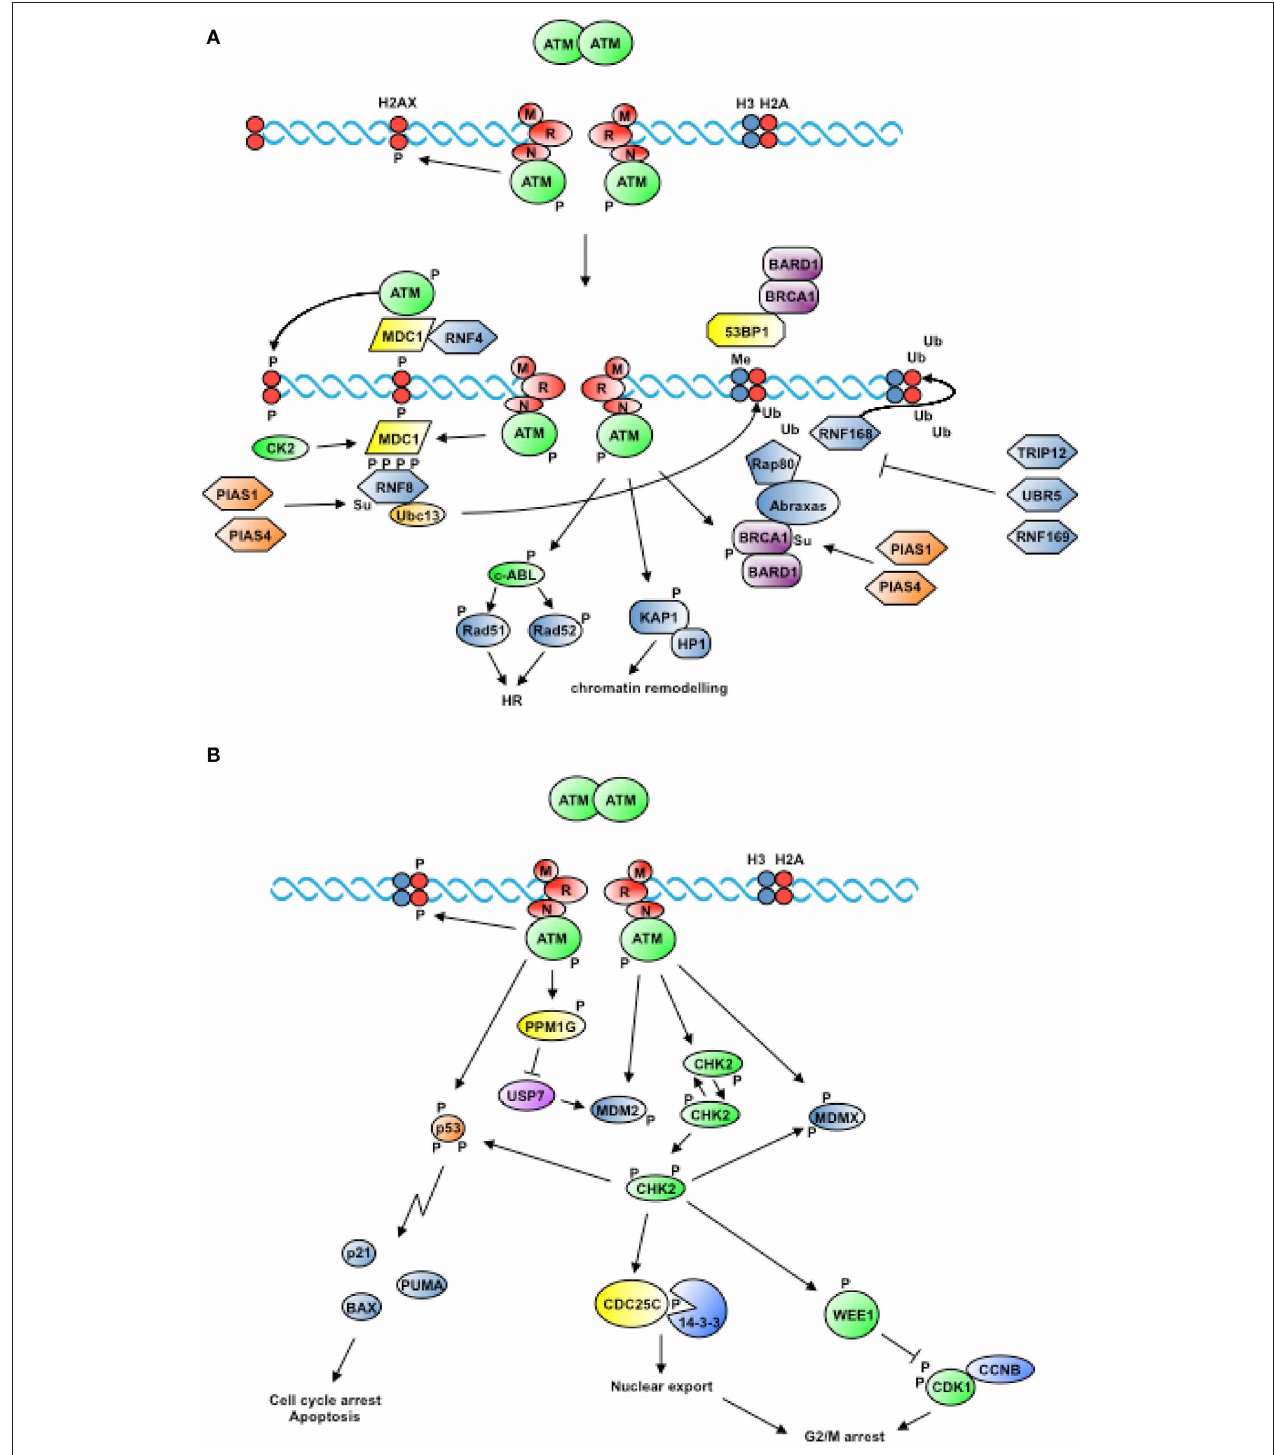
FIGURE 2 | Proximal and widespread DNA damage signals. (A) In response to the generation of DSBs, ATM is recruited to DNA in an MRN-dependent manner and is activated by autophosphorylation. ATM-dependent phosphorylation of H2AX triggers the recruitment of factors that mark the site of damage and cooperate to amplify the signal. In addition, ATM phosphorylates proteins that contribute to